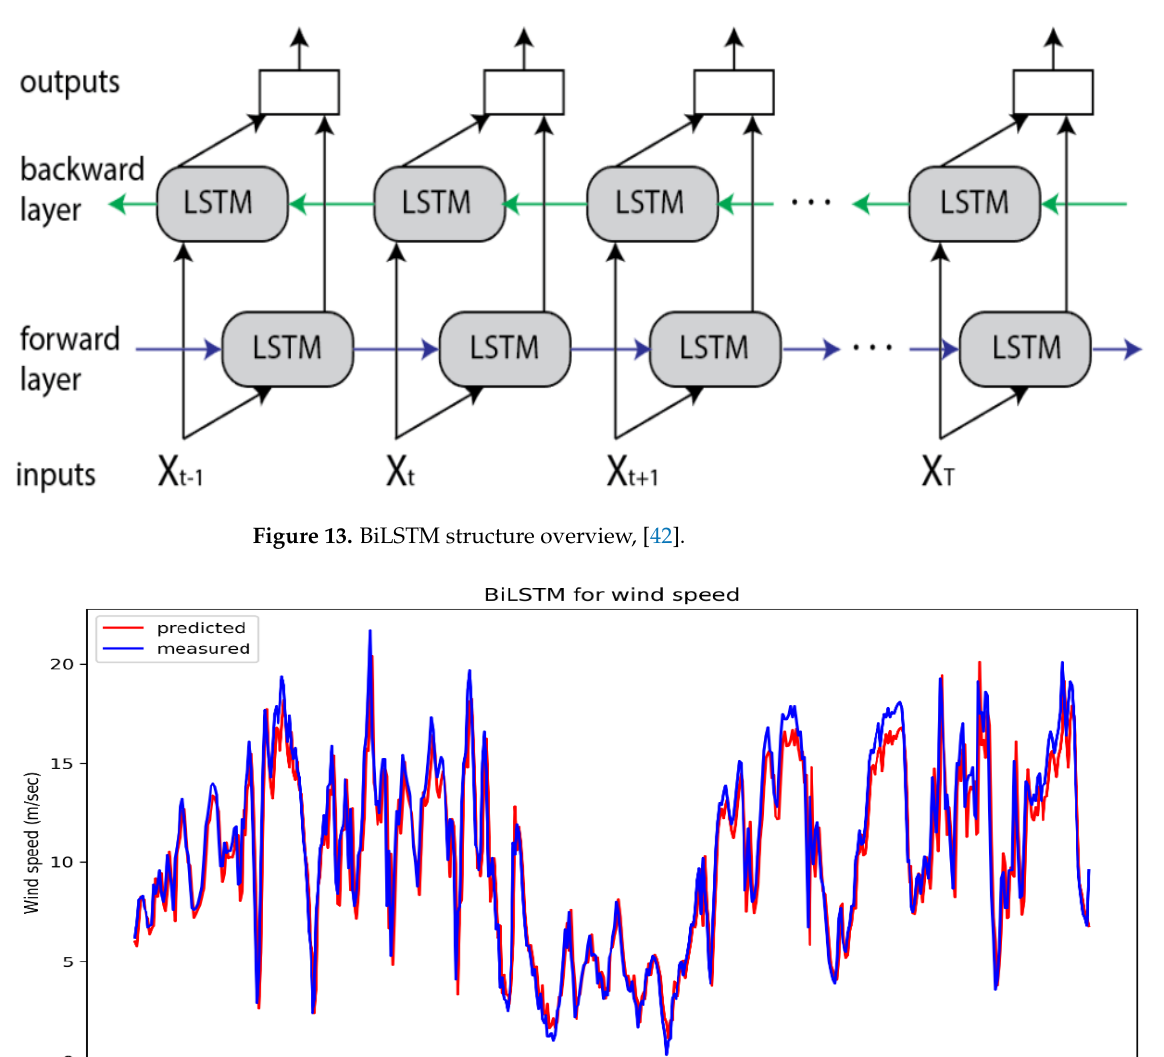
Figure 14. BiLSTM wind speed prediction.